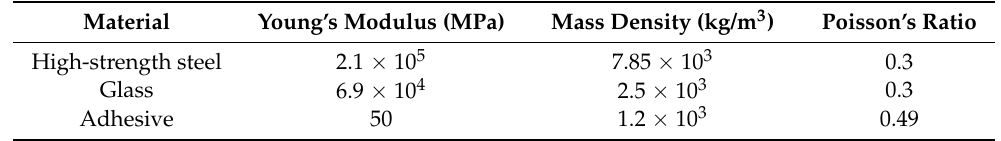
Table 1. Material properties of finite element